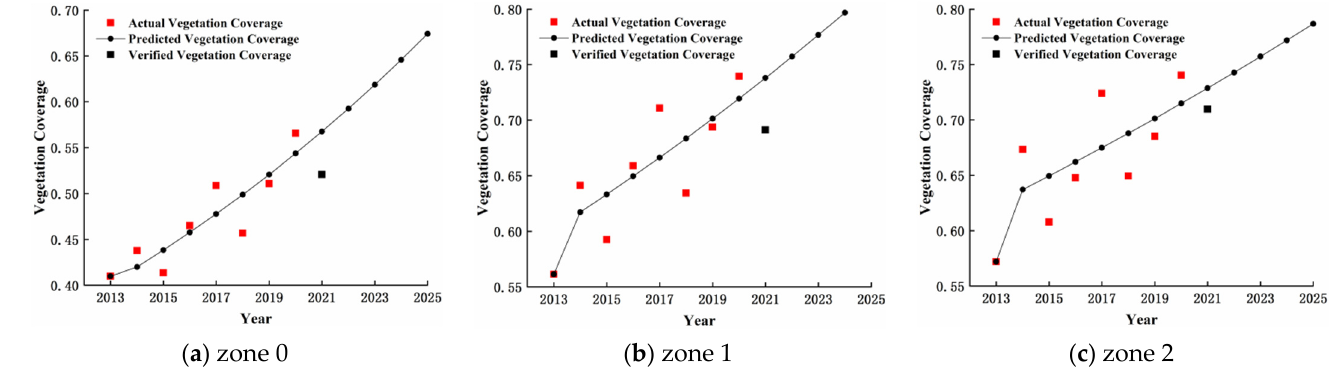
Figure 5. The predicted VC trends using the grey forecasting model in 0, 1, and 2 zones.